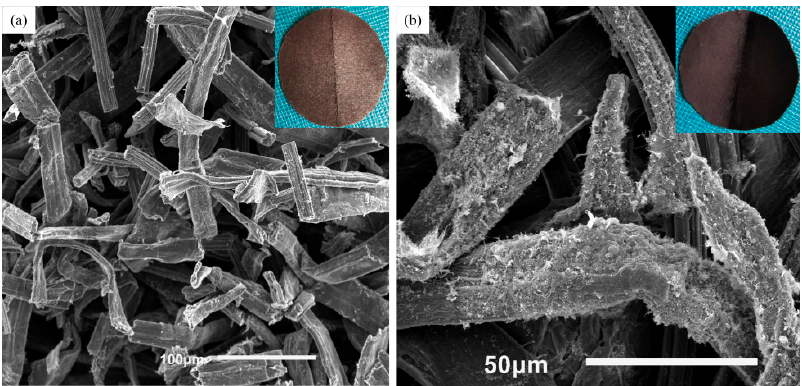
Figure 7. ( a ) SEM image of the AS electrode (ZnO/CNT/FP) after bending. ( b ) SEM image of the AS electrode (Fe 3 O 4 /CNT/FP) after folding.